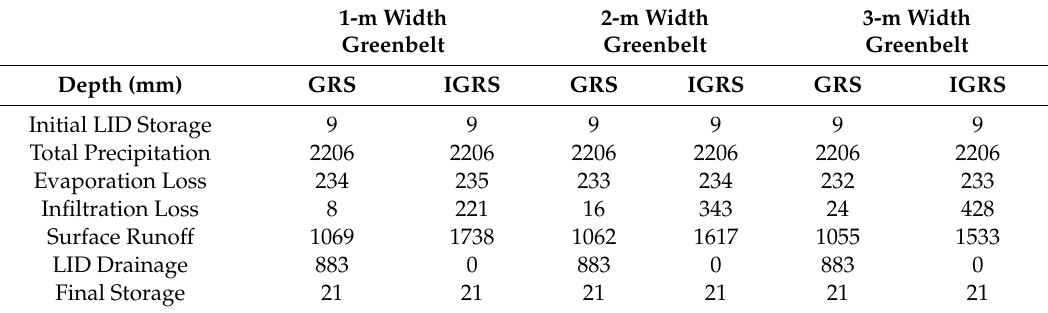
Table 10. Comparison of the GRS and IGRS in continuous simulation in